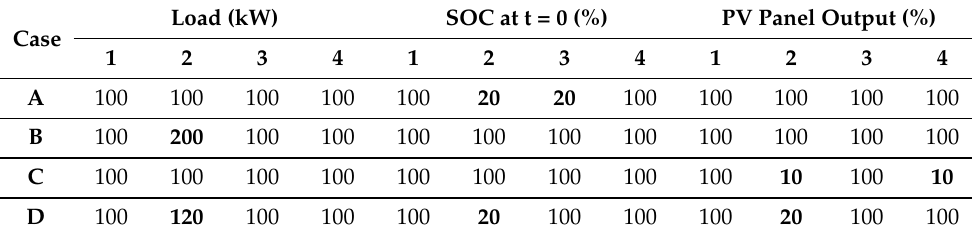
Table 2. The Details of Parameters Used for Case